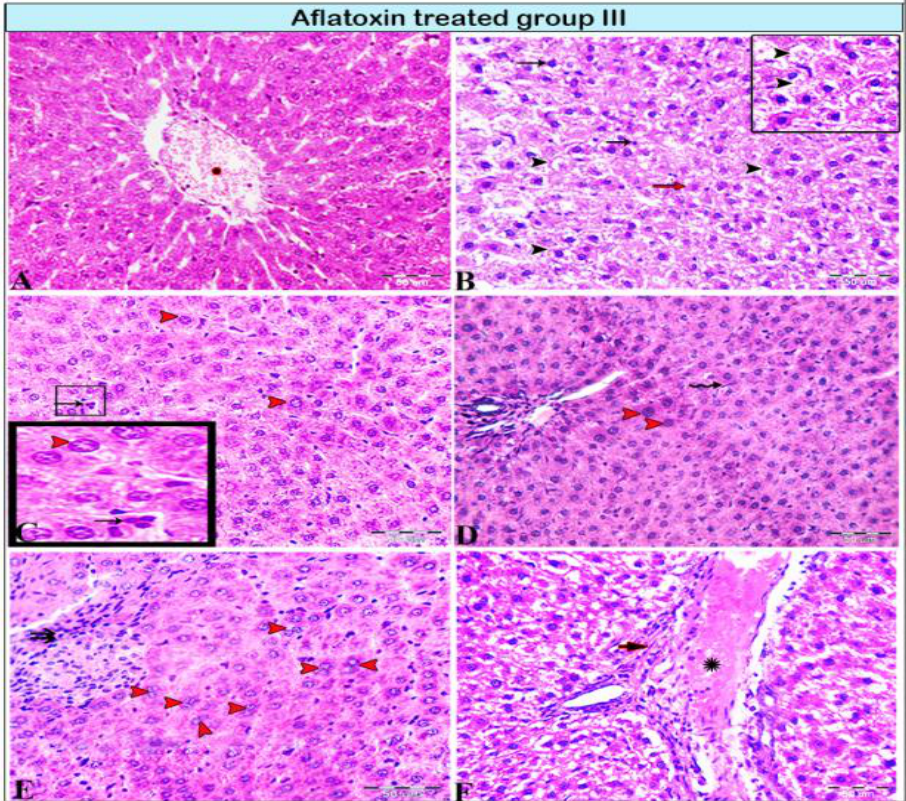
Figure 3. Photomicrograph of a rat liver in aflatoxin B1-treated group III (8-week treatment). ( A ) Extensive central vein congestion and thrombosis (star). ( B ) Vacuolar degeneration of hepatocytes (black arrowheads, magnified in the black square) and hepatocellular necrosis; pyknotic cellular nucleus (black arrows) or karyolitic nucleus (red arrow). ( C, D ) Hepatic megalocytes (red arrowheads), abnormalities in mitosis with tripolar mitosis (C: squares and black arrows, respectively), and Kupffer cell proliferation (D: black arrows). ( E ) Degenerated binucleated hepatocytes (red arrowheads); a focal area of necrosis; several adjacent hepatocytes are absent and replaced by inflammatory cells (double arrows). ( F ) Marked dilatation in the portal vein (star) with periportal fibrosis